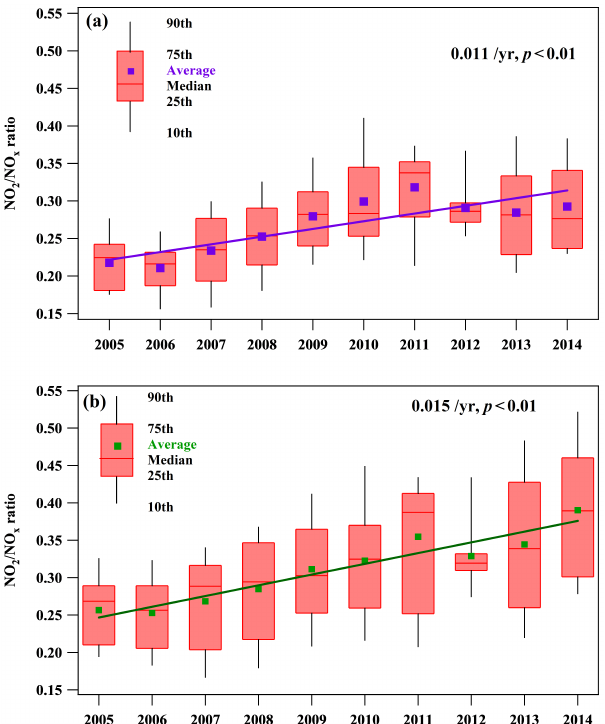
Figure 7. Annual trend of monthly average NO 2 / NO x ratio at MK site in daytime (a) and night-time (b) in Hong Kong in the period 2005–2014. Hourly observations of NO 2 and NO x are obtained at MK from the HKEPD (http://epic.epd.gov.hk/ca/uid/airdata). Note that data of October in 2014 are excluded due to the impact of Oc- cupy Central event in Hong